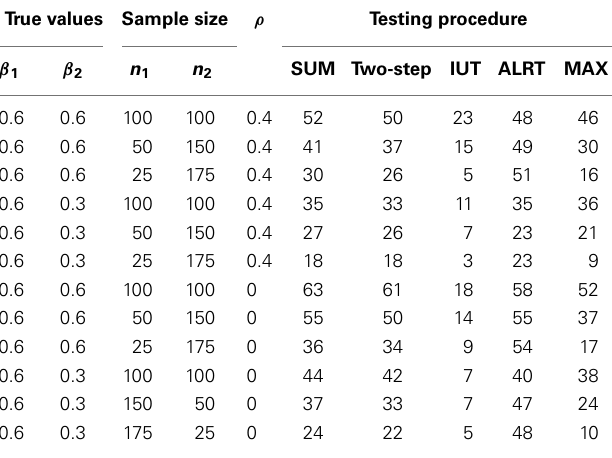
Table 3 | Simulation results: size and power (%) with different true value positions.